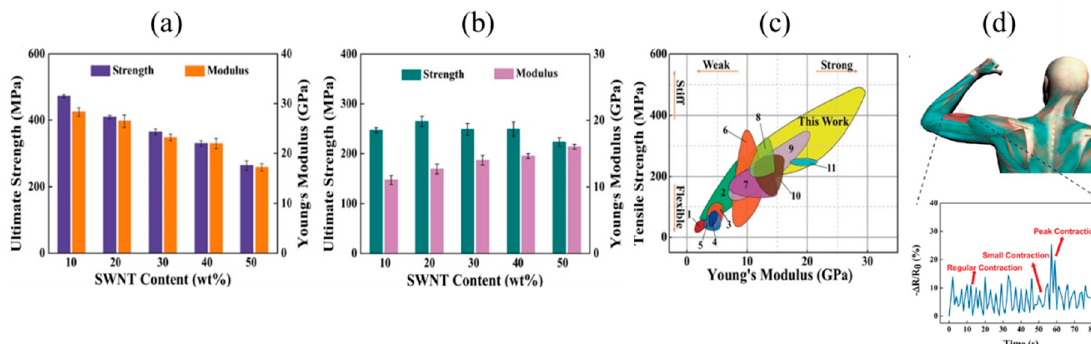
Figure 6. Mechanical properties of the filaments ( a ) Young’s modulus and ultimate strength of five different filaments investigated in this work at 12% relative humidity (RH). ( b ) Young’s modulus and ultimate strength of five different filaments investigated in this work at 50% RH. ( c ) Tensile stress and Young’s modulus map to compare different types of CNF/CNT composites. (1) CNF/MWNT films, (2) CNF/MWNT nanopapers, (3) CNF/fluorinated CNT films, (4) CNF/MWNT films, (5) CNF/SWNT films, (6) CNF/SWNT films, (7) CNF/SWNT membranes, (8) CNF/SWNT membranes, (9) CNF/MWNT nanopapers, (10) CNF/MWNT microfibers, and (11) CNF/SWNT microfibers. ( d ) Application of sensor that can record slight changes in electrical resistance and